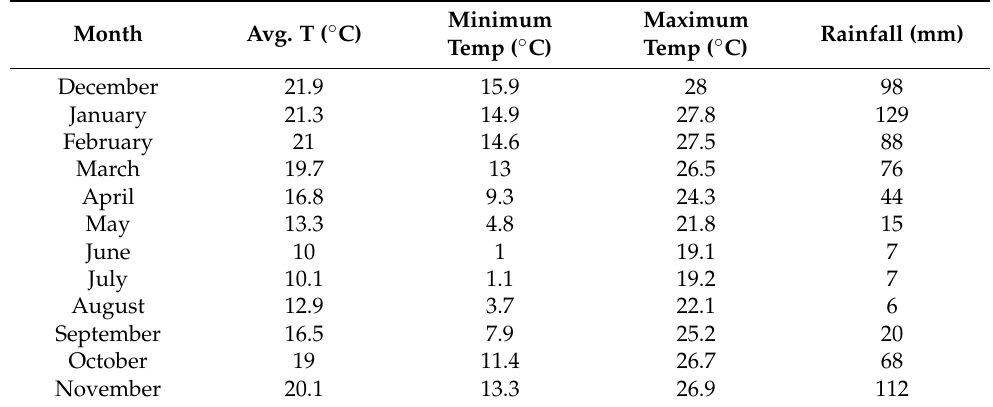
Table 2. Weather data for Bronkhorspruit/Gauteng during the year 2019/2020.